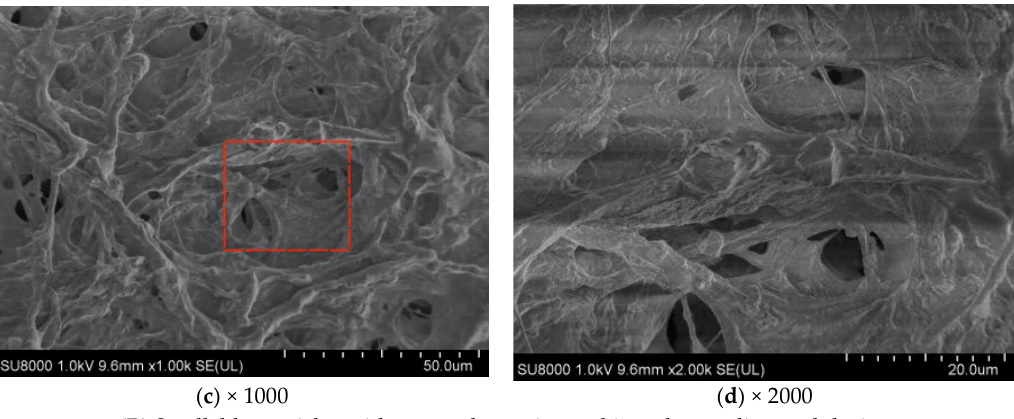
Figure 4. SEM images of the swellable particles before and after water absorption.